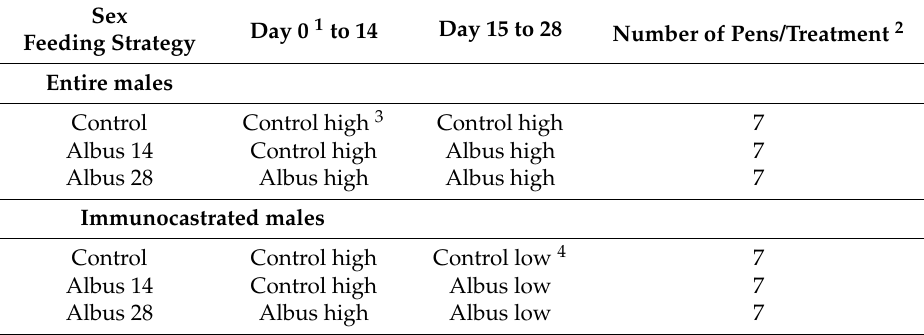
Table 3. Diets fed to each sex and feeding strategy for the periods day 0 to 14 and day 15 to 28. Sex Day 0 1 to